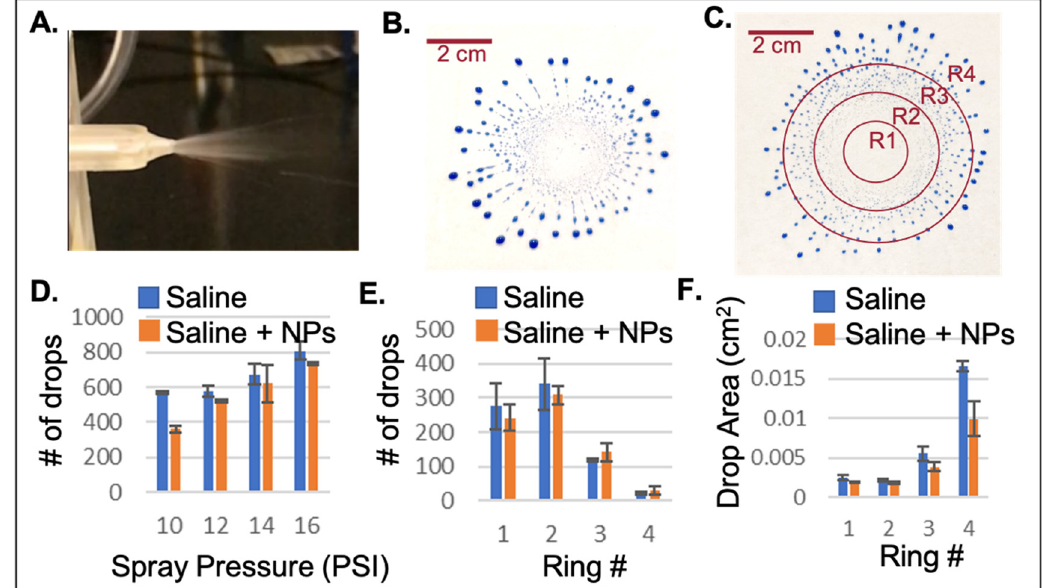
Figure 9. Optimization of the spray characteristics for aerosolized drug delivery to physiologically small animals. ( A ) Photo of the appearance of the aerosolized solution using a time lapse video. ( B ) Example plume captured using blue dye on a filter paper backdrop. ( C ) Separation of the plume into 4 successively larger rings (R1, R2, R3, and R4), analyzed using MATLAB. ( D ) Analysis of the spray pressure and number of drops generated. Ideal conditions would minimize the number of drops. A total of 10–12 PSI was the optimal pressure to emit a minimum of 90% of the solution from the chamber in physiological conditions (data not shown). ( E ) The plume characteristics revealed maximum aerosolization centrally within rings 1 and 2. ( F ) The aerodynamic diameters of the droplets within R1, R2, and R3 were approximately 5, 50, and 500 µm, respectively. The majority of the R1 droplets were expected to reach the olfactory region.